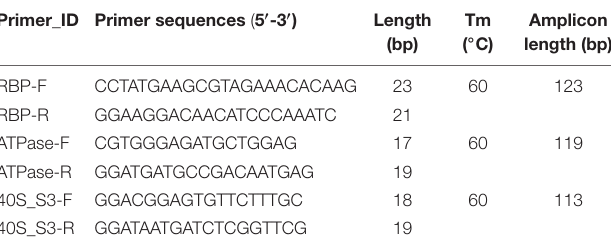
TABLE 1 | Detailed primer information for RBP , ATPase , and 40S_S3 . Primer_ID Primer sequences ( 5 (cid:48) -3 (cid:48)